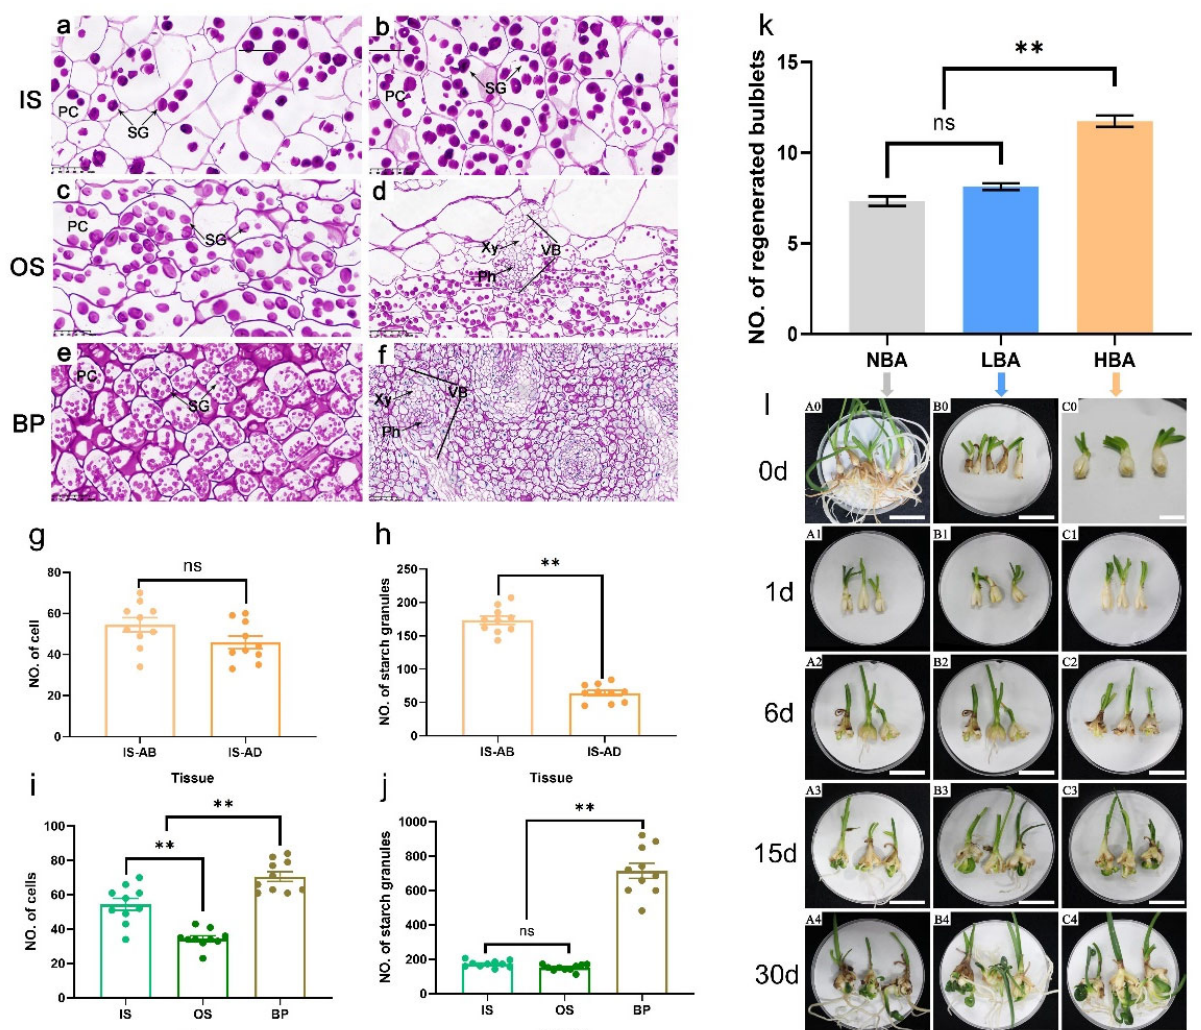
Figure 1. Tissue characteristics of bulblets of Lycoris sprengeri and statistical analysis of the regenerated bulblets in response to 6-benzyladenine (BA), treatments. ( a – j ): Histological observations and statistical analysis of clonal bulblet of Lycoris sprengeri . ( a ) Scale abaxial side, ( b ) Scale adaxial side; Parenchymal cells ( c ) and vascular bundle ( d ) of outer scales; Parenchymal cells ( e ) and vascular bundle ( f ) of basal plate. Number of parenchymal cells ( g ) and starch granules ( h ) in abaxial and abaxial side of scales of clonal bulblet under the same field of view. Number of parenchymal cells ( i ) and starch granules ( j ) in scales and basal plate of clonal bulblet under the same field of view. The solid circles are biological replicate data ( n = 10). The central values represent the means, and the error bars indicate the SEM of all biological replicates. ( k ) Number of regenerated bulblets in media supplemented with 0, 0.5 and 5.0 mg L − 1 BA, respectively. Data are represented as the means ± SEM ( n = 15 biological replicates). ( l ) Morphological observations of bulblet regeneration in three BA treatments from 0 d to 30 d. Bar = 3 cm. NBA, group with no BA treatment, LBA, group with low concentration of BA treatment, HBA, group with high concentration of BA treatment. AB: abaxial, AD: adaxial, IS: inner scales, OS: outer scales, BP: basal plate, SG: starch granules, PC: parenchymal cells, Ph: phloem, Xy: xylem. Asterisks indicate significant differences within each column (Duncan’s multiple range test, ** p < 0.01).